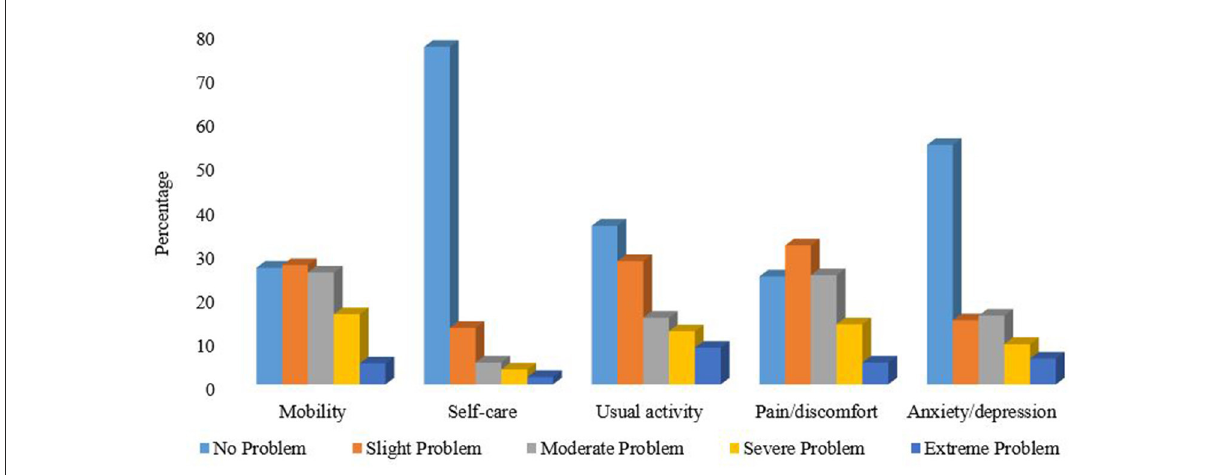
FIGURE1 Self-reported health problems using the EQ-5D-5L descriptive dimensions in patients with Cardiovascular disease.